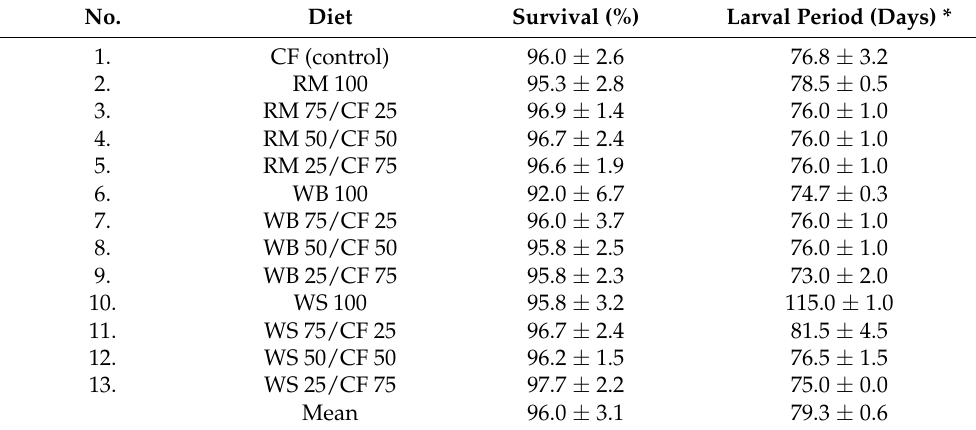
Table 3. Survival and larval stage duration (from hatching to pupation) of larvae grown on different agro-industrial